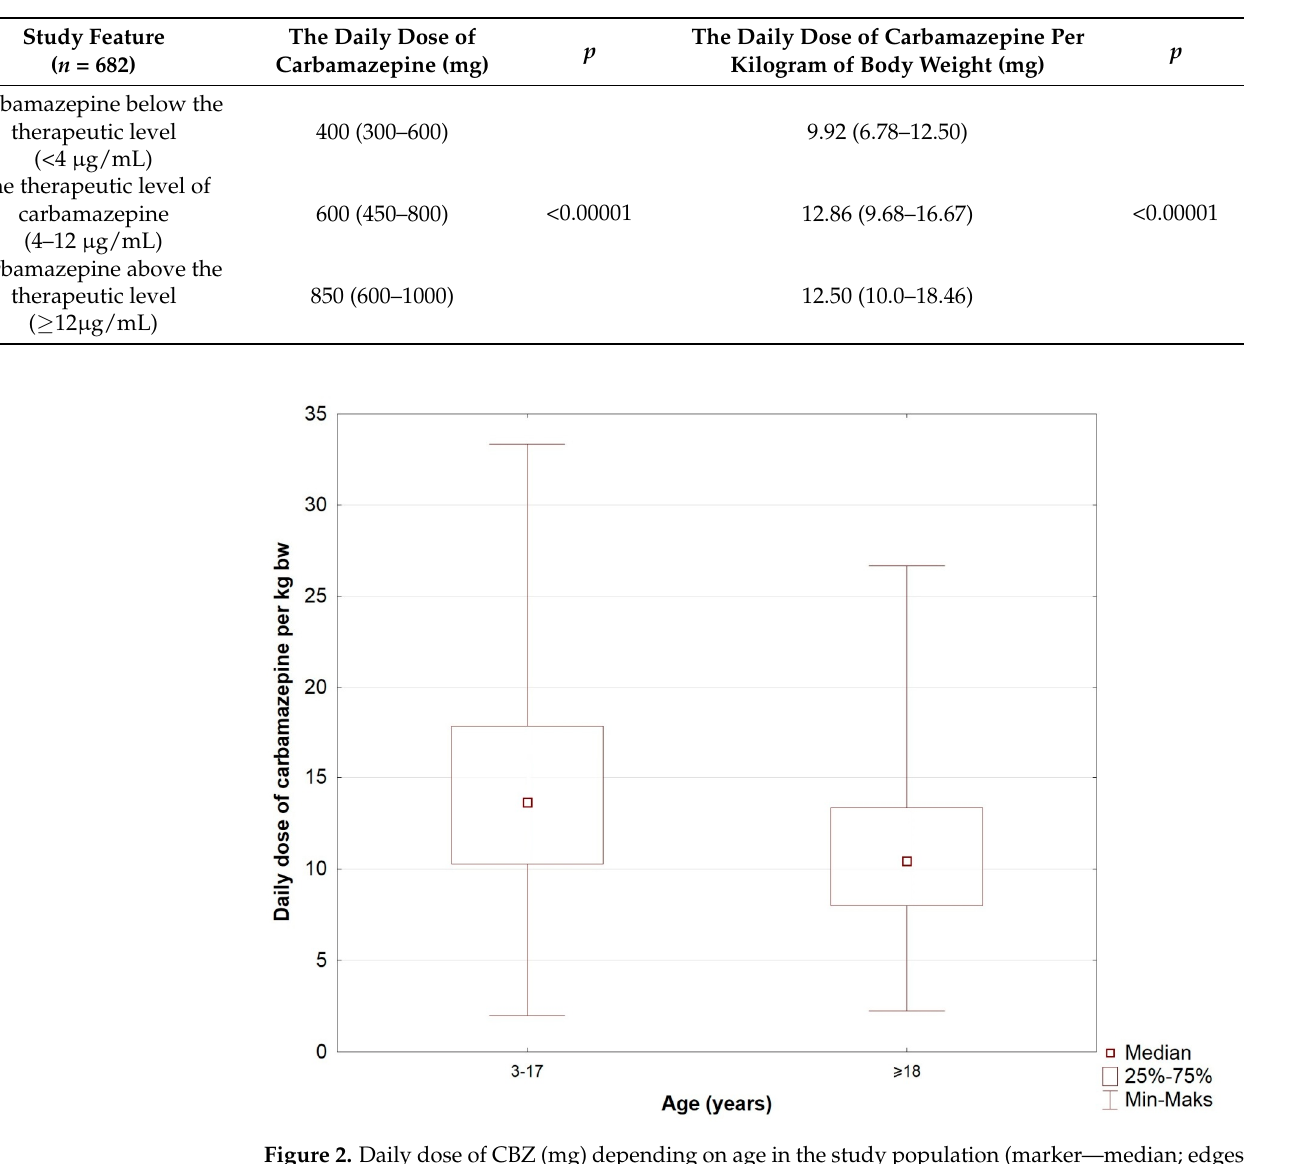
Figure 2. Daily dose of CBZ (mg) depending on age in the study population (marker—median; edges of the box—upper and lower quartile; whiskers—range of non-outlier values). In the study population (excluding patients with no dose data and who made a suicide attempt), statistically significant differences were found depending on the main reason for hospitalization and age ( p = 0.003) (Table 4). In both age groups (3–17 and ≥ 18 years old), epilepsy was the dominant cause of hospitalization. In addition, there was a higher proportion of elderly patients with a suspected drug overdose and a suicide attempt. In terms of gender, epilepsy was also the main reason for hospitalization. There was a higher proportion of women with a suspected drug overdose and a much higher proportion of men with a suicide attempt, although the observed differences did not reach statistical significance. Statistically significant differences were found depending on age and the number of doses of the drug taken per day (p = 0.0100). Patients from both age groups most often took CBZ twice a day (among patients between 3 and 17 years of age the percentage was 73.3%, and after the age of 18 years it amounted to 64.7%). Younger people were more often treated with one dose a day (4.0% vs. 2.5%) but less frequently with at least 3 doses a day (22.7% vs. 32.8%). No statistically significant differences were found depending on sex and the number of doses taken per day. In the female population of